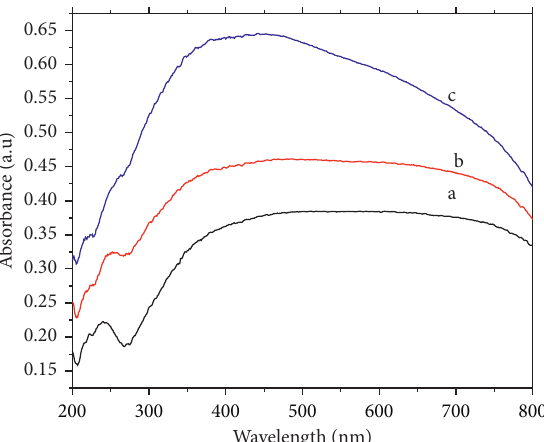
Figure 6: UV-V is spectra of CuO NPs synthesized using copper (II) nitrate trihydrate and Catha edulis leaf extract in (a) 1:10, (b) 3 :10, and (c) 1: 2 ratios